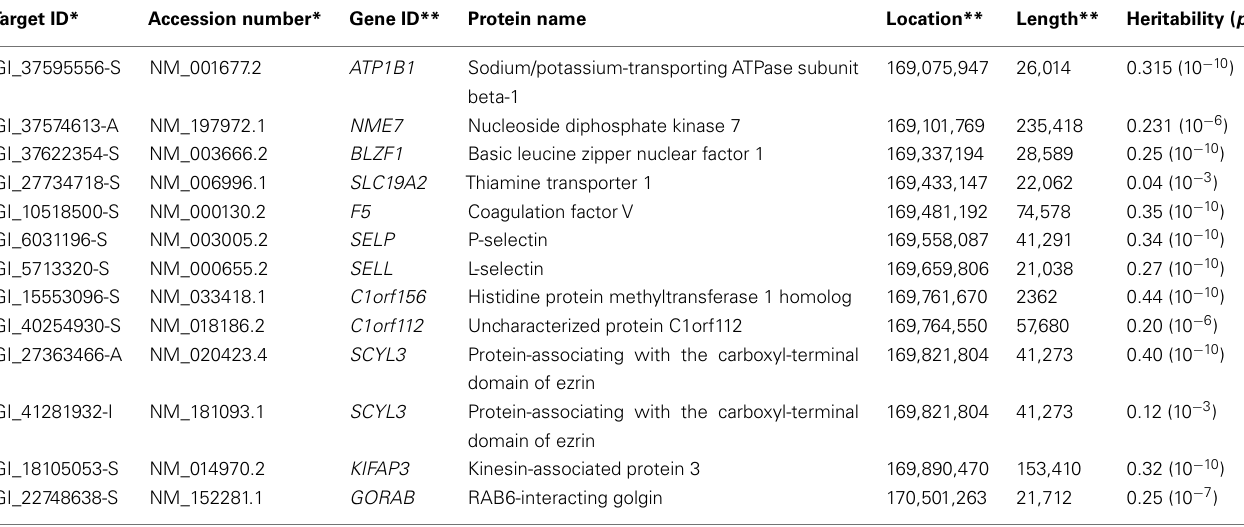
Table 1 |Thirteen measurements of gene transcriptions were available for 12 genes located on chromos 1q24 between markers rs137915045 and